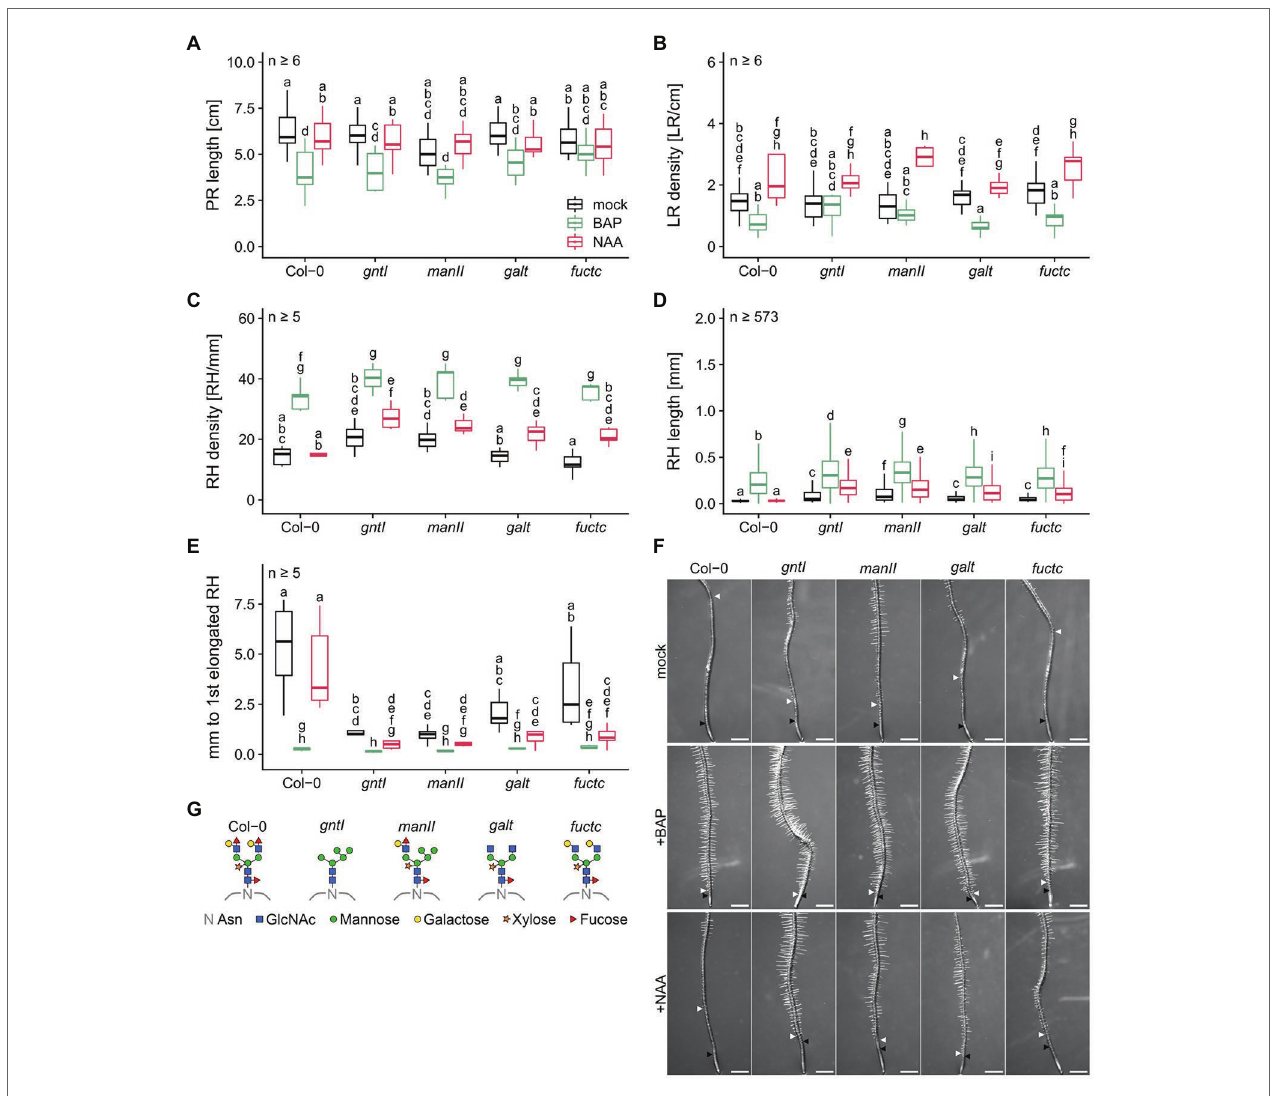
FIGURE 1 | Plants lacking fully matured complex N-glycans differ in the root hair landscape and are auxin hypersensitive. (A) Primary root length, (B) lateral root density, (C) root hair density, (D) root hair length, and (E) distance between first general and first partially elongated root hair of N-glycosylation mutants and wild- type plants cultivated for 8 days on mock (black boxes), 15 nM BAP (green boxes), or 15 nM NAA (red boxes). Letters indicate significant differences between groups [ p ≤ 0.05; (A–C,E) two-way ANOVA with Tukey post hoc test; (D) Kruskal-Wallis test, FDR corrected via Benjamini-Hochberg]. (F) Pictures of wild type (Col-0) and N-glycosylation mutant root tips. Black arrows indicate the first general root hair while white arrows point to the first partially elongated root hair. Scale bars: 500 μ